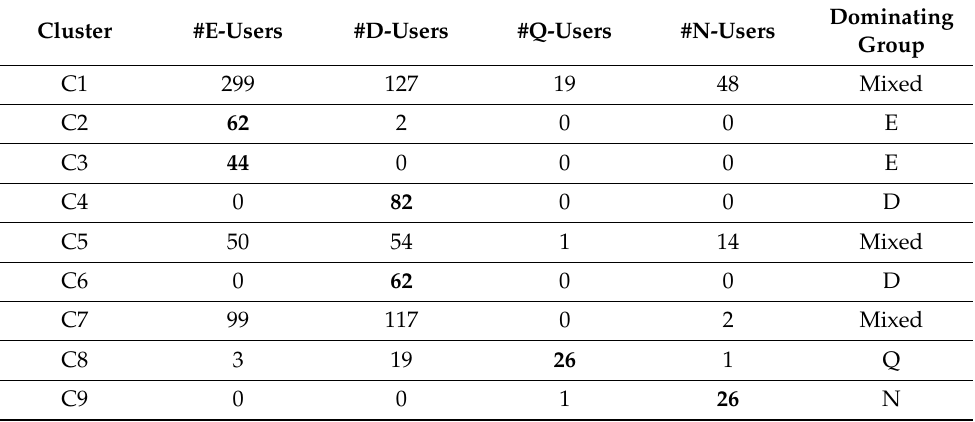
Table 5. Membership of users in